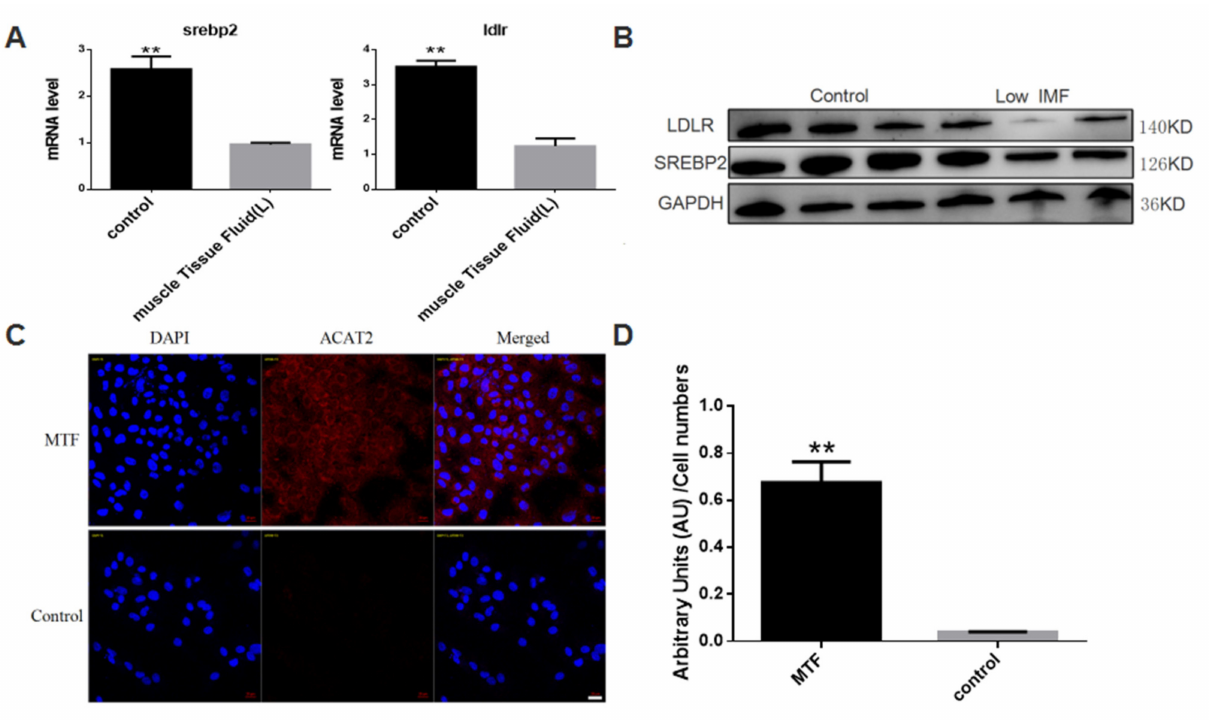
Figure 3. Muscle tissue fluid of pig with low intramuscular fat level can affects srebp2/ldlr level of adipocytes. ( A ) mRNA levels of SREBP2 and LDLR in the groups of muscle tissue fluid treated and control. ( B ) protein levels of SREBP2 and LDLR in the groups of muscle tissue fluid treated and control, GAPDH as an internal reference. ( C ) pig intramuscular preadipocytes treated with muscle tissue fluid of low intramuscular fat individual for 12 h. Representative images by confocal microscopy are presented ( n = 3). ( D ) Fluorescence intensity of pig intramuscular preadipocytes treated with muscle tissue fluid of low intramuscular fat individual for 12 h, quantified by IntDen/Cell Numbers ( n = 3). Data are expressed as means ± SEM ( n = 3), representative of 3 independent experiments. The statistical significance was calculated by One-way ANOVA, ** p < 0.01. Scale bar = 20 µ